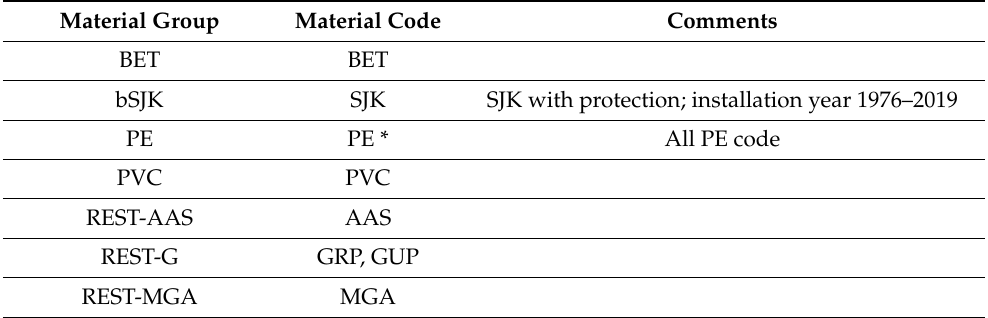
Table A1. Grouping of pipes based on pipe metadata (material, age/installation